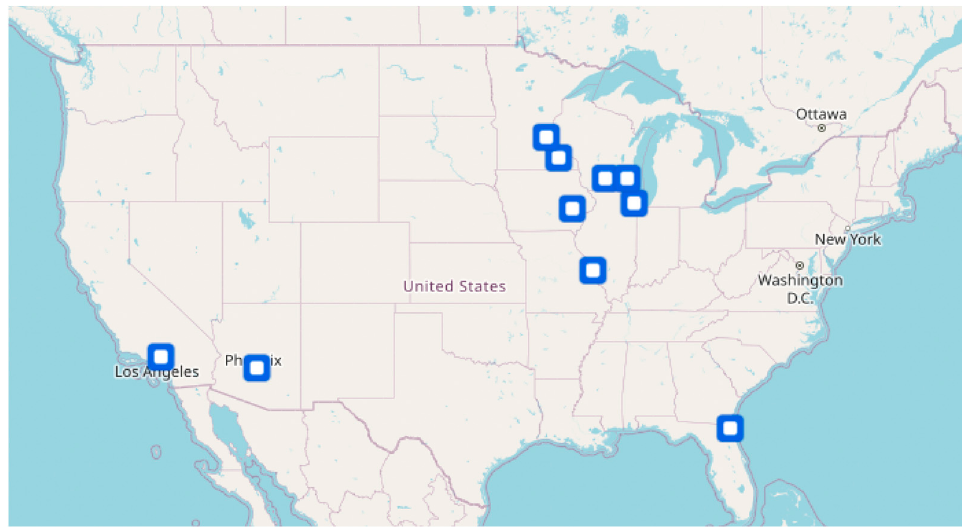
Figure 1. MWSTP Anchor Site